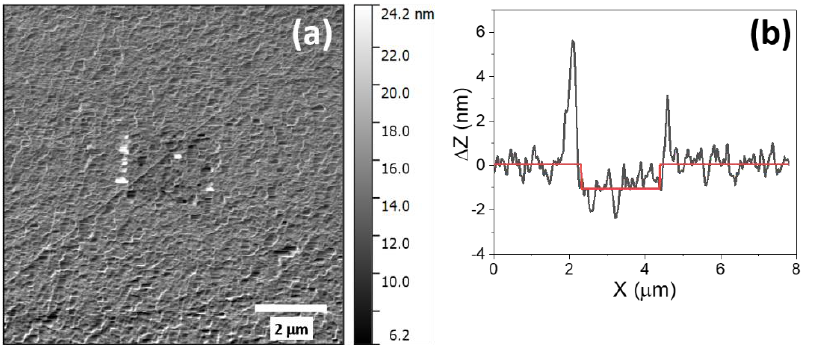
Figure 3. ( a ) ΔZ difference image obtained via AFM of an ITO_Lac surface before and after removal of a 2 × 2 μm 2 region of the organic film. ( b ) Average height profile extracted from the ΔZ image in ( a ).